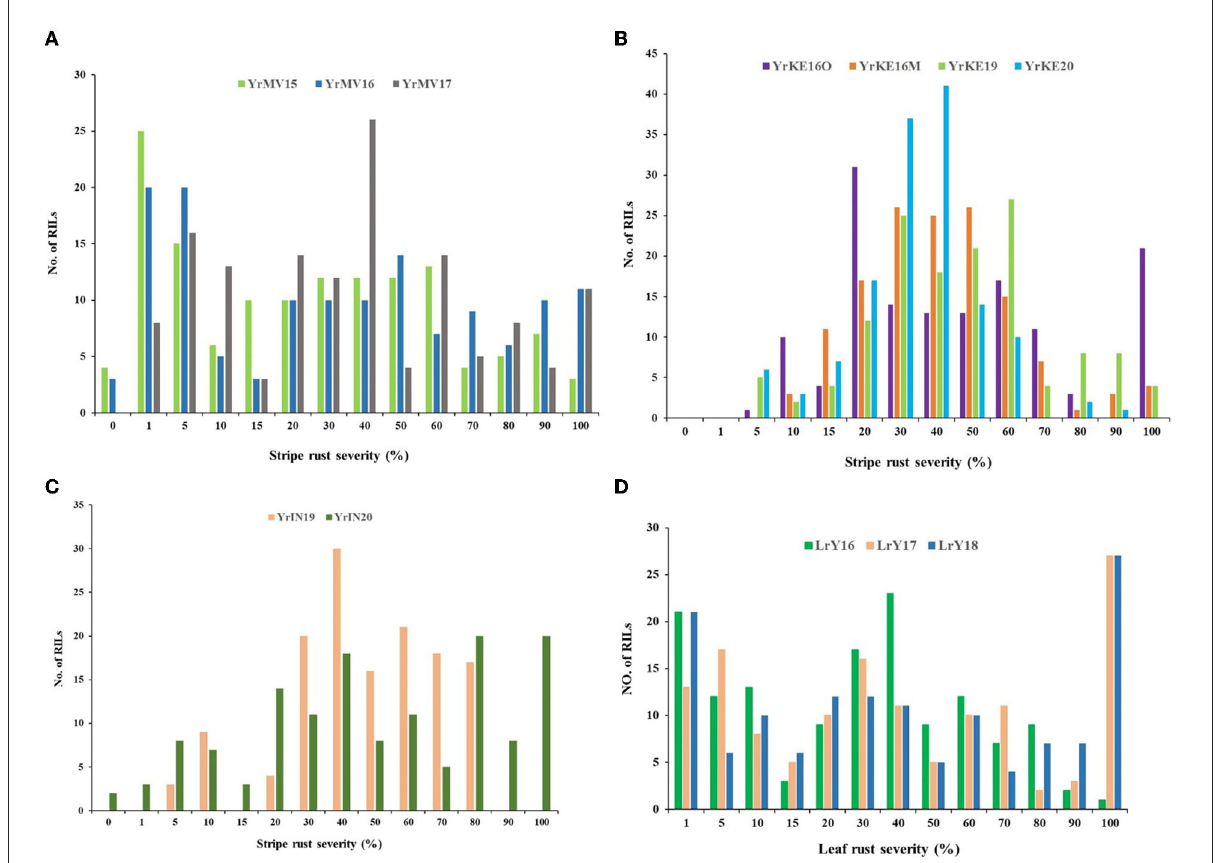
FIGURE2 Frequency distributions of Apav#1 × Mucuy recombinant inbred lines (RILs) for the final stripe rust severities in three environments in Mexico (A) , four environments in Kenya (B) , and two environments in India (C) , along with final leaf rust severities in three environments in Mexico (D)